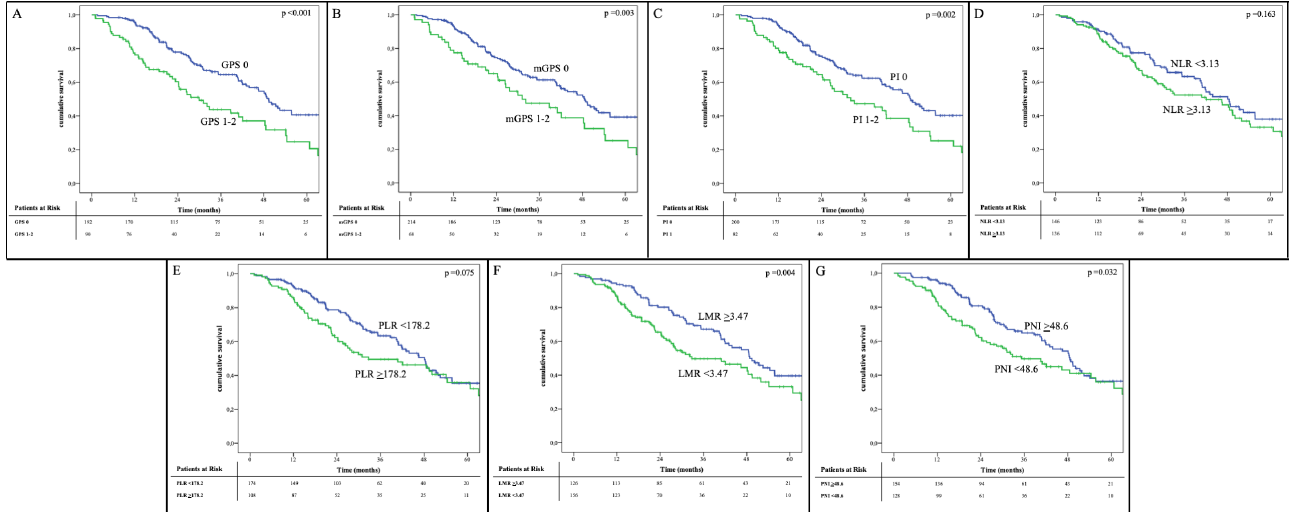
Figure 1. Survival curves according to the inflammatory and nutritional prognostic scores: ( A ) Glasgow Prognostic Score (GPS); ( B ) modified Glasgow Prognostic Score (mGPS); ( C ) Prognostic Index (PI); ( D ) Neutrophil to Lymphocyte ratio (NLR); ( E ) Platelet to Lymphocyte ratio (PLR); ( F ) Lymphocyte to Monocyte ratio (LMR); ( G ) Prognostic Nutritional Index (PNI).